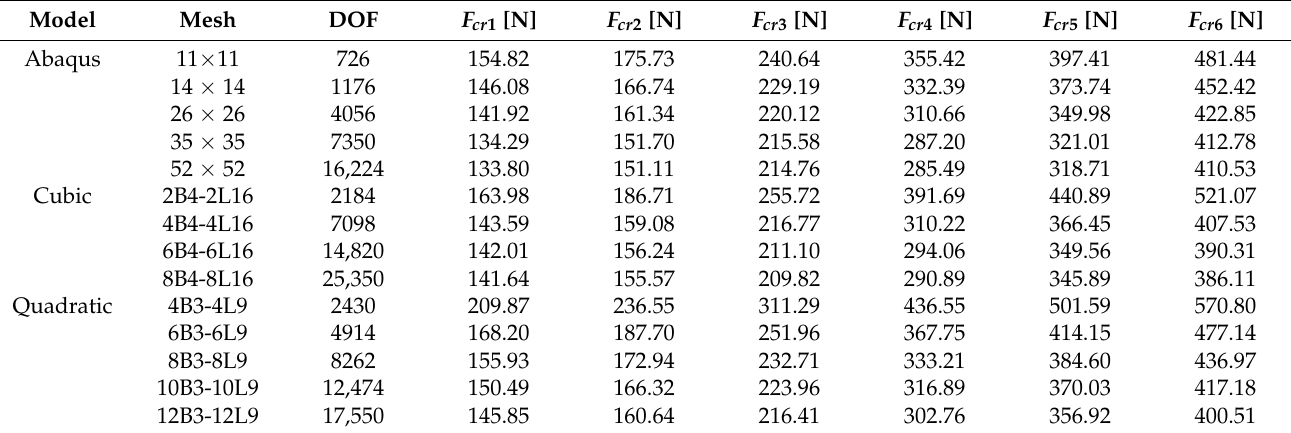
Table 3. Convergence of the buckling load for the Case 1 pristine structure. A uniform fibre volume V f = 0.60 is considered and no fibre